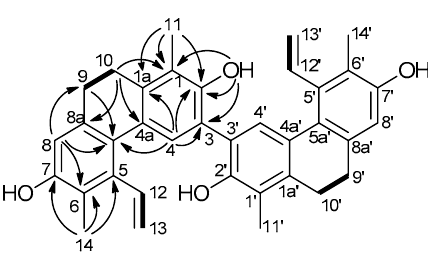
Figure 3. Diagnostic COSY ( ▬ ) and HMBC (H → C) correlations of Compound 2 .